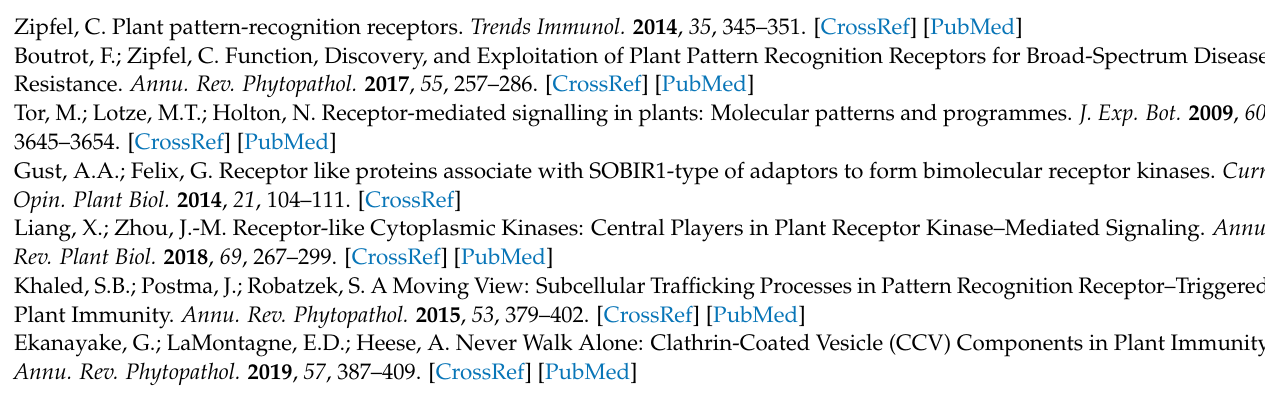
orthologues; Figure S2. SlDRP1s expression in tomato leaves; Figure S3: SlDRP1B and SlDRP2A comparison; Figure S4: Effect of overexpression of SlDRP1B on FLS2-mediated oxidative burs; Figure S5: Effect of overexpression of SlDRP3A on LeEIX2-mediated defense; Figure S6: LeEIX2 localization ratio at PM; Table S1. Description of interacting proteins of SlDRPs; Table S2. Interactome interaction scores; Table S3: Co-expressed genes list of SlDRP1B, SlDRP1C, and SlDRP2A; Table S4. Gene ontology analysis; Table S5. List of specific real-time PCR primers used for SlDRP1s gene expression